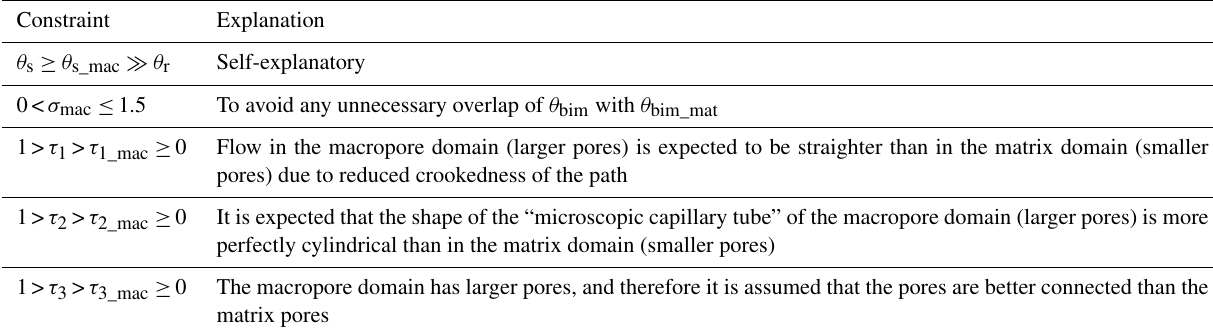
Table 3. Theoretical constraints of the K s_bim model.